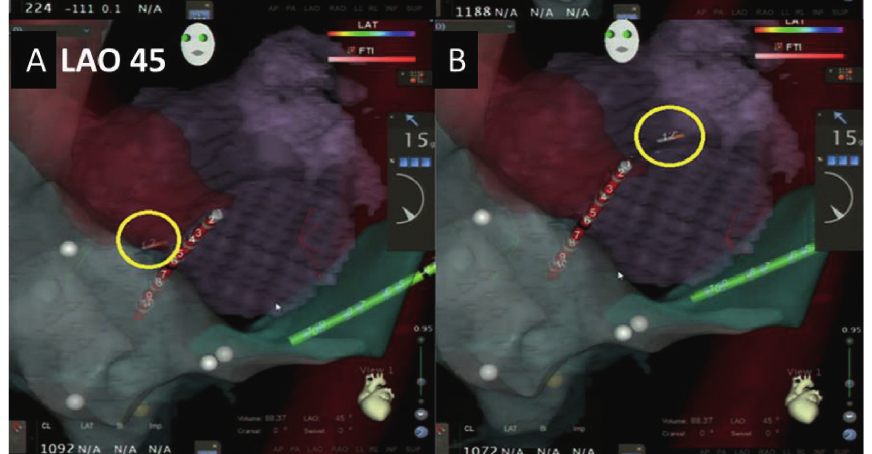
Figure 2: Direct visualization (yellow circle) of the needle tip on the electroanatomical mapping system (Left Anterior Oblique Projection): needle tenting on the fossa ovalis (A) and in the left atrium (B). FAM of right atrium (RA) merged with the 3D reconstruction of a preacquired CT scan and two decapolar catheters in His and coronary sinus (CS) position. Ao: